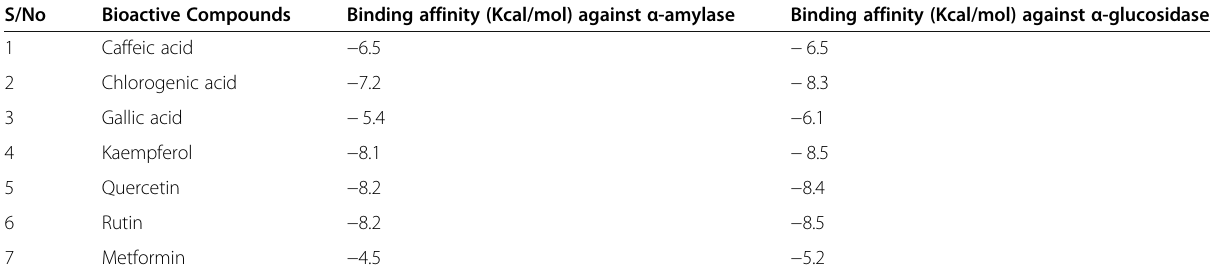
Table 4 AutoDockVina results for each bioactive compound with their binding affinity against α -amylase and α -glucosidase